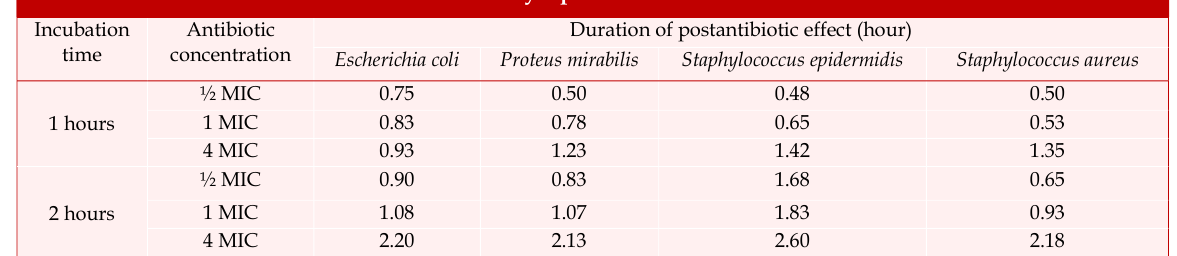
Postantibiotic effect induced by ciprofloxacin on different bacterial strains Incubation Antibiotic time concentration